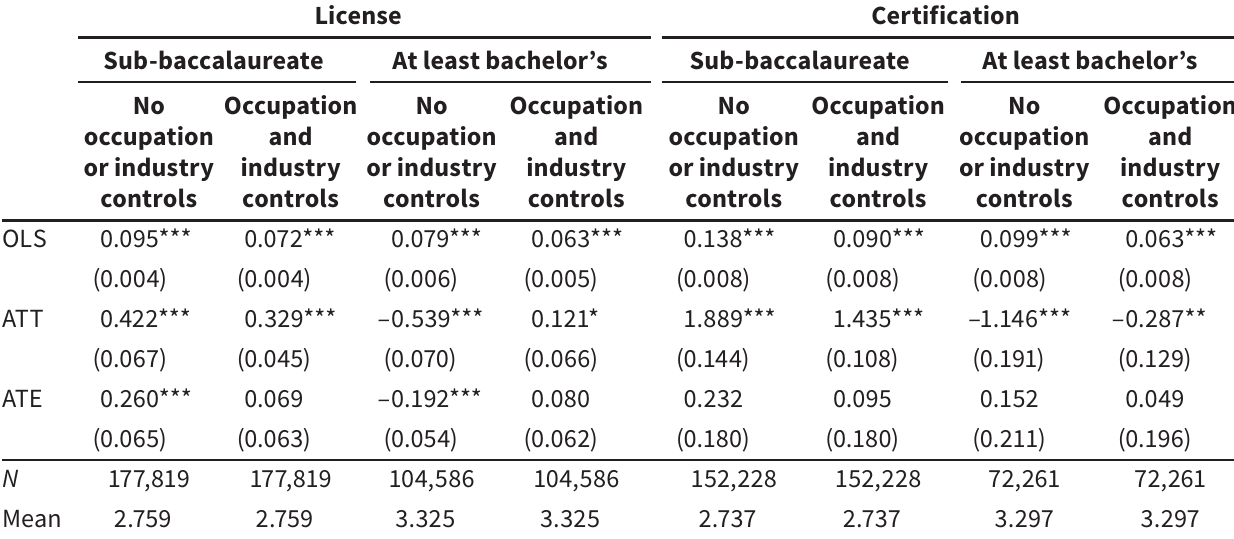
Effects of credential-holding on log wages by level of